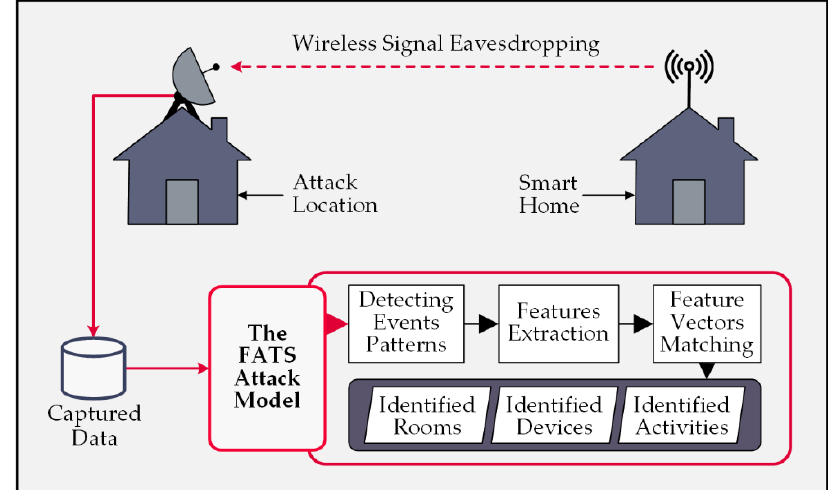
Figure 5. Overview of the FATS attack processes.